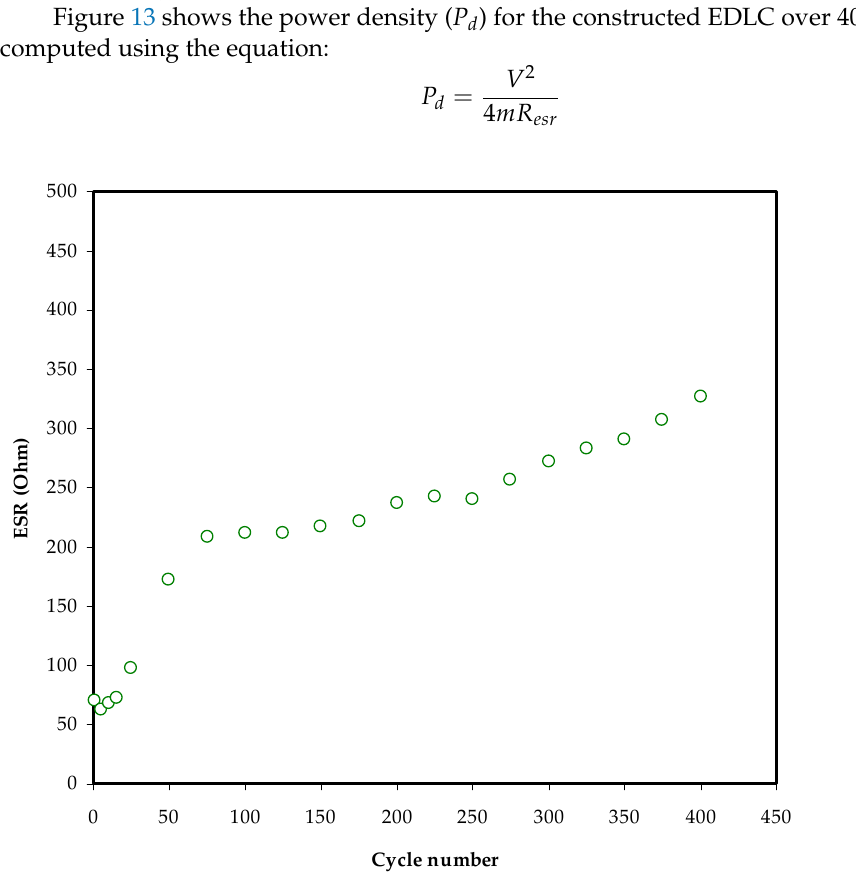
Figure 10. The R esr of the EDLC for 400 cycles.